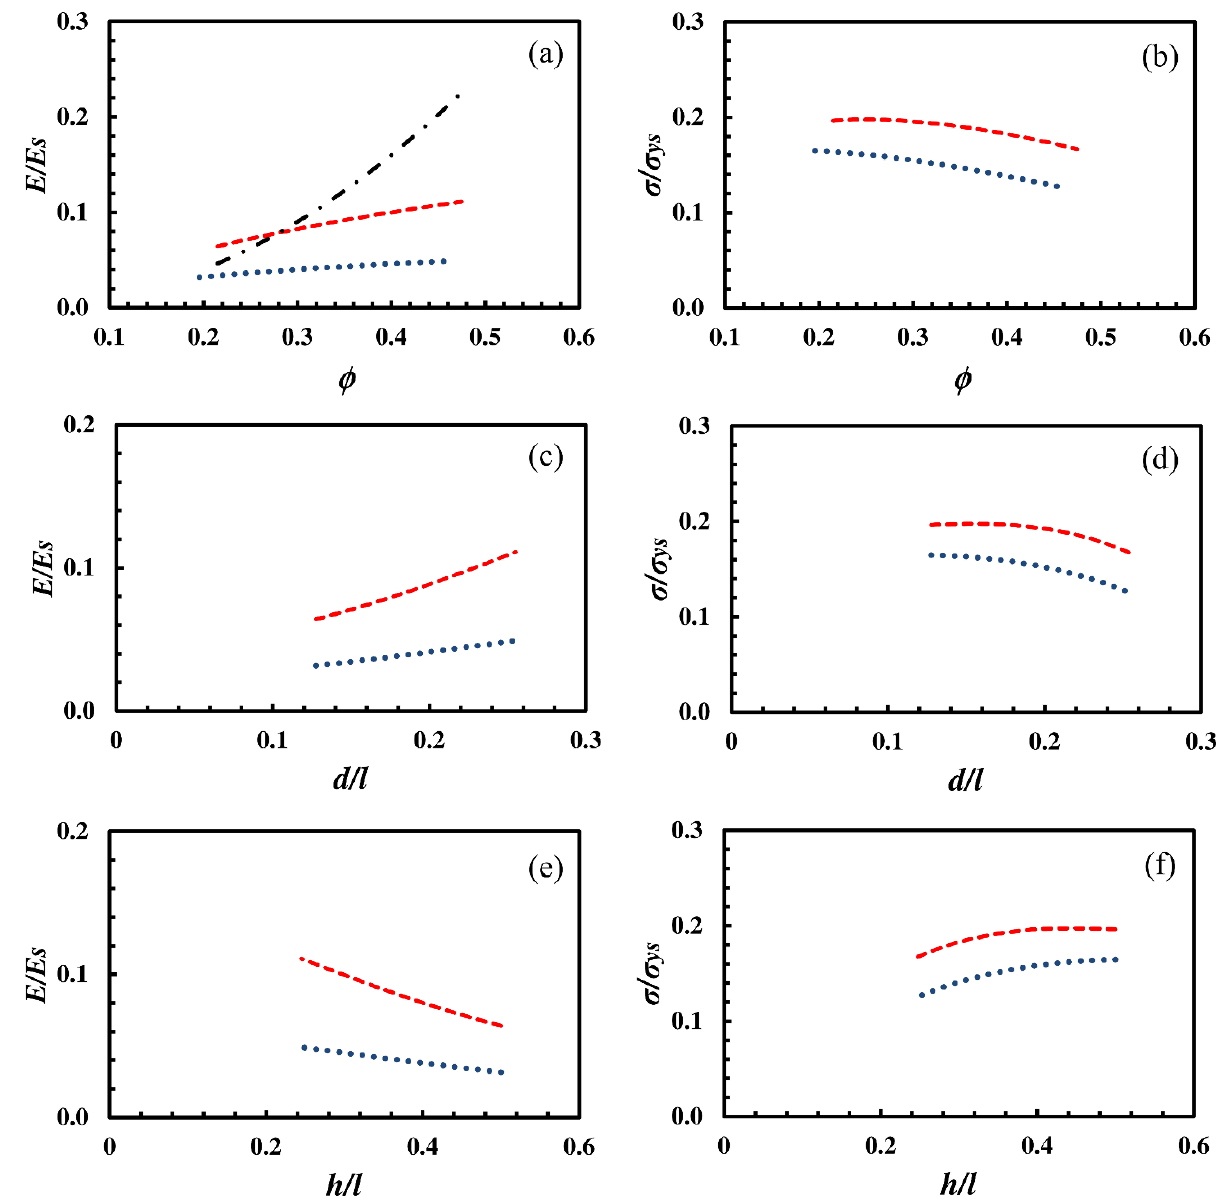
Figure 8. The relative Young’s modulus E / E s and the relative yield strength σ/σ ys as a function of relative density ϕ, respectively ( a ) and ( b ); of the ratio d / l , respectively ( c ) and ( d ); and of the ratio t / l , respectively ( e ) and ( f ). Results were obtained keeping t / l constant at the value of 0.245. Dashed ( ‒ ‒ ‒ ) and dotted (• • •) lines refer to the cases of ligaments with square and circular cross-sections, respectively. Dash-dot line ( − · − · ) indicates the values obtained with Gibson and Ashby’s